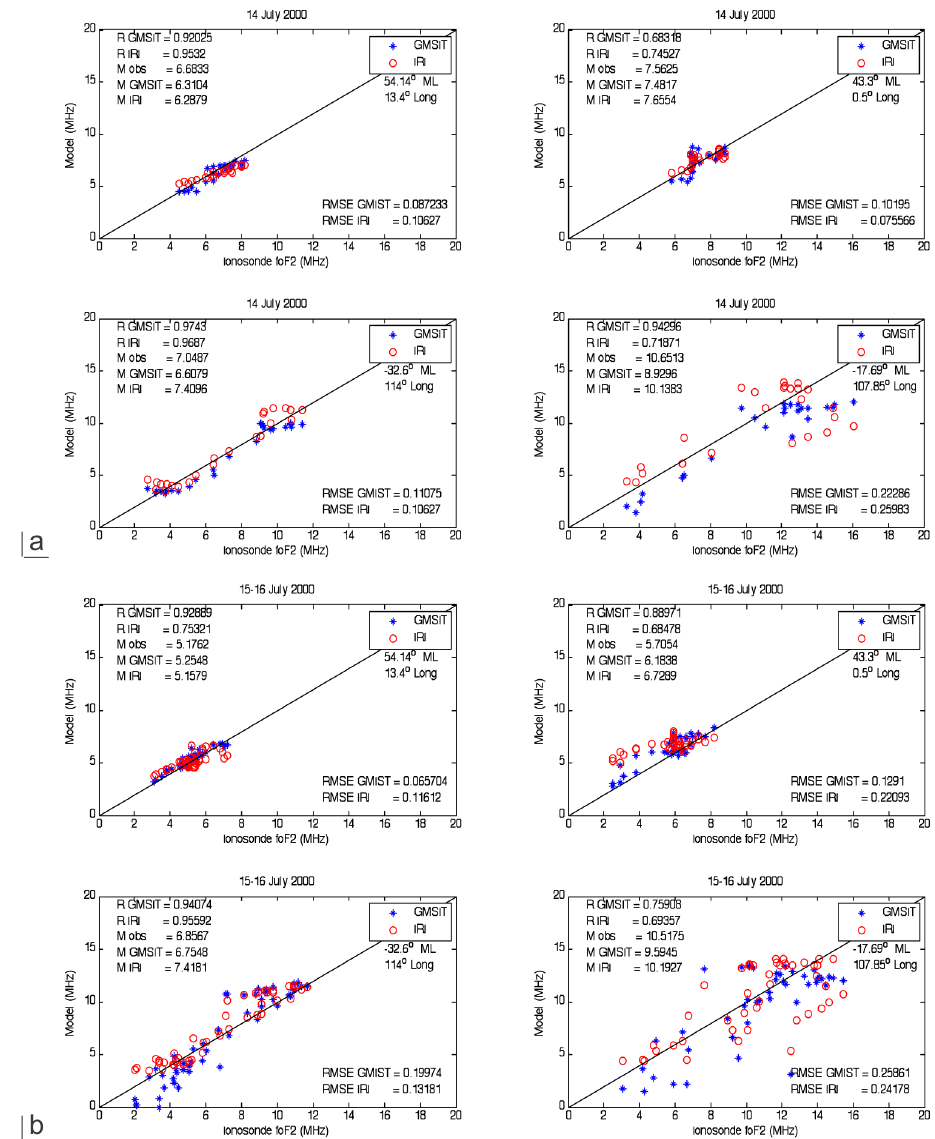
Figure 4. Scatter diagram between modeled (GMIST and IRI STORM) and observed foF2 values during (a) quiet day and (b) geomagnetic storm on July 15-16, 2000, at ionospheric stations of different regions of the globe. The geomagnetic latitude and geographic longitude of each station is given at the upper-right edge of each